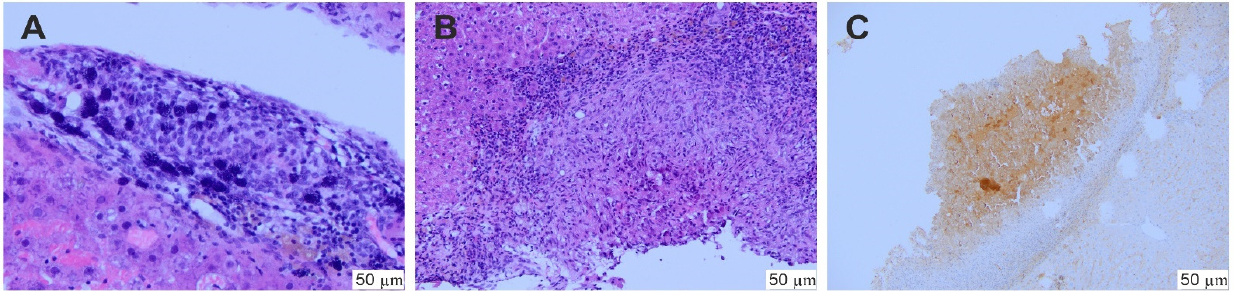
Figure 7. Histological assessment of the biopsy. ( A ) Hepatoma cells, ( B ) a minor tumor with severe fibrosis and inflammation; ( C ) hepatoma confirmation—immunochemical reaction for alpha-fetoprotein.